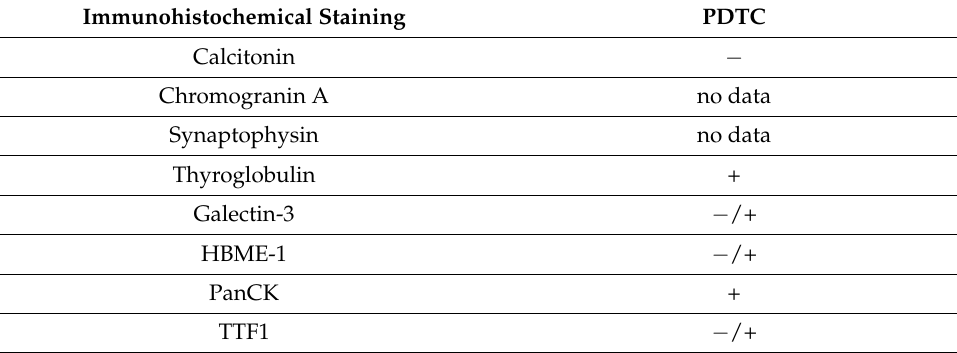
Table 2. Common immunohistochemical staining used in poorly differentiated thyroid carcinoma